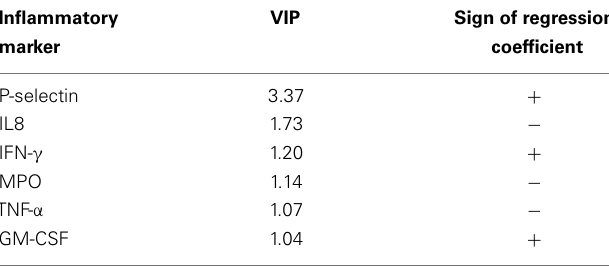
Table 3 | Inflammatory biomarkers mostly involved in the discrimination between gait speed categories